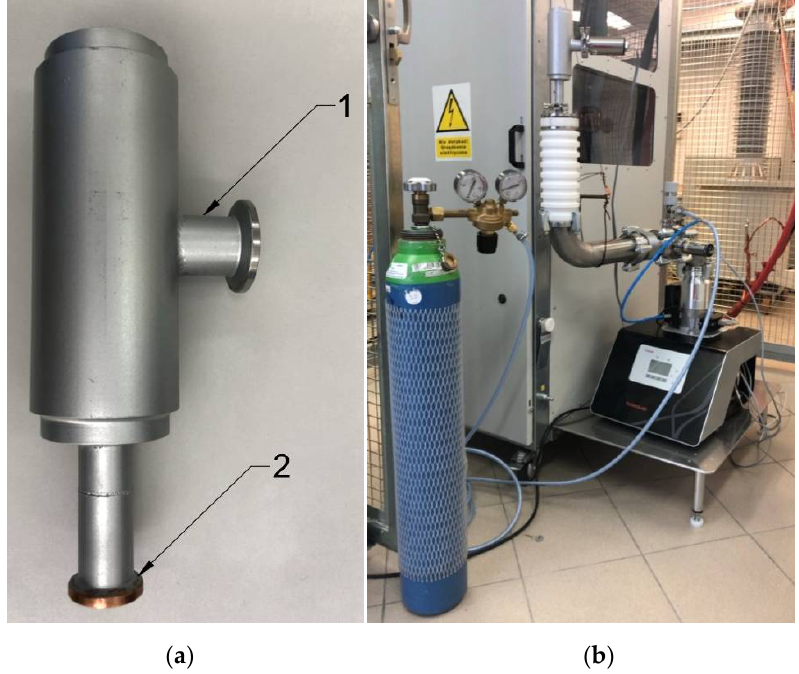
Figure 2. Test stand: ( a ) prototype of a vacuum interrupter designed to determine the actual pressure value in test objects (1—vacuum gauge connection, 2—pump channel connection), ( b ) view of the complete test stand.